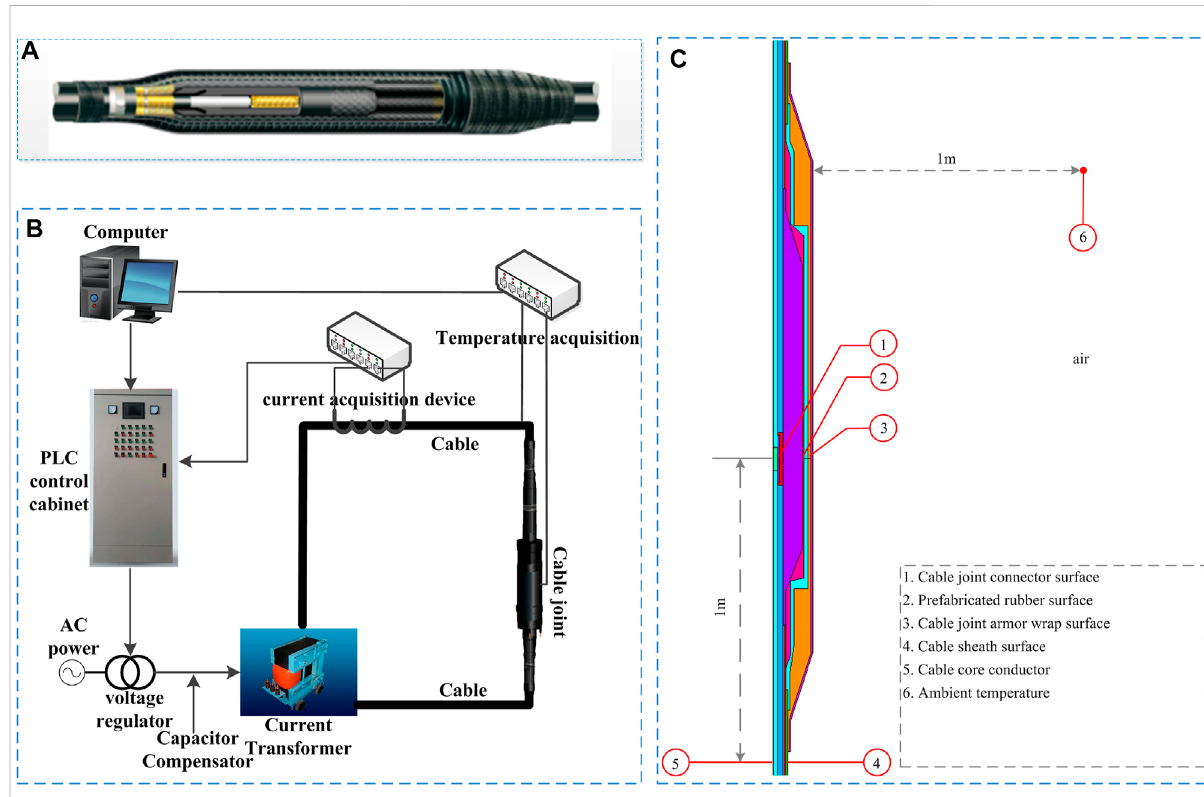
FIGURE 4 Temperature-rise test platform. (A) Cable joint. (B) Schematic diagram of the temperature-rise test platform. (C) Distribution of temperature measuring points on the quarter section of the cable